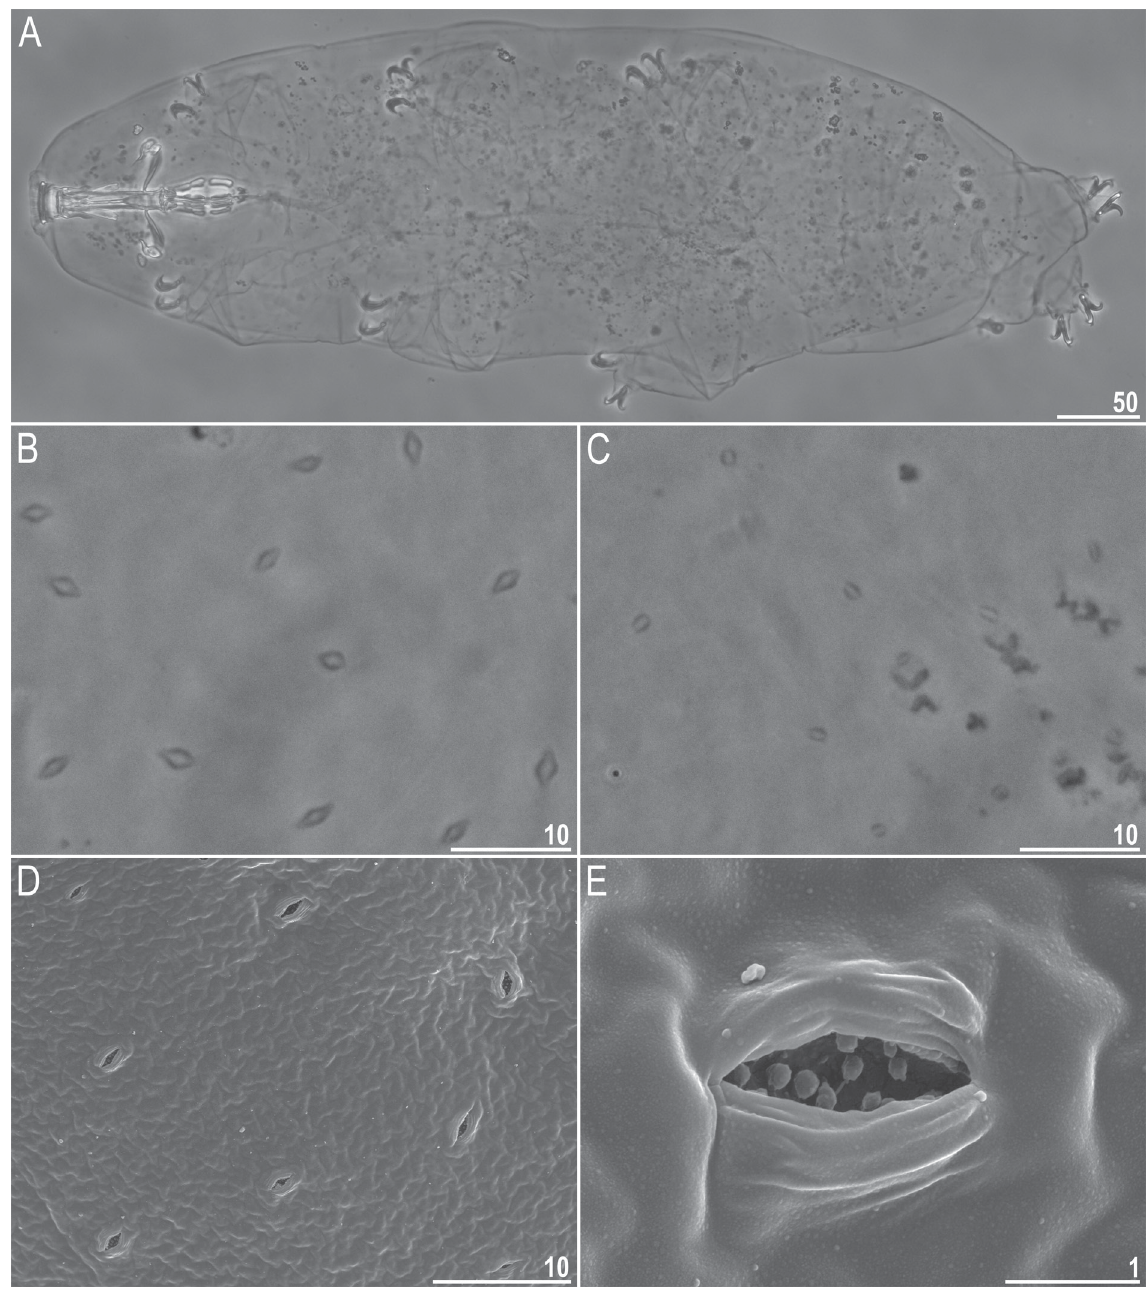
Fig. 8. Macrobiotus cf. recens Cuénot, 1932 , Gran Canaria, habitus and cuticular pores. A . Dorso- ventral projection (PCM). B–C . Pores on the dorsal and ventral cuticle, respectively (PCM). D . Pores on the dorsal cuticle (SEM). E . Granulation inside a single pore (SEM). Scale bars in